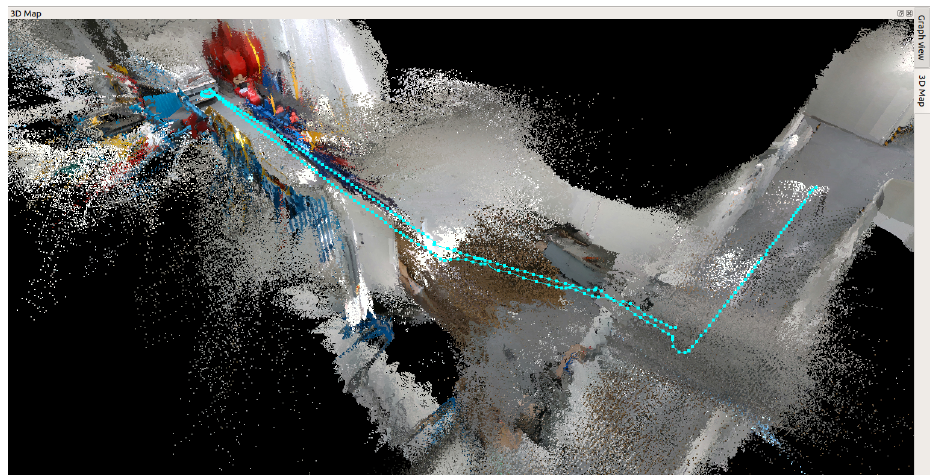
Figure 18. 3D map made during the autonomous driving with the robot’s